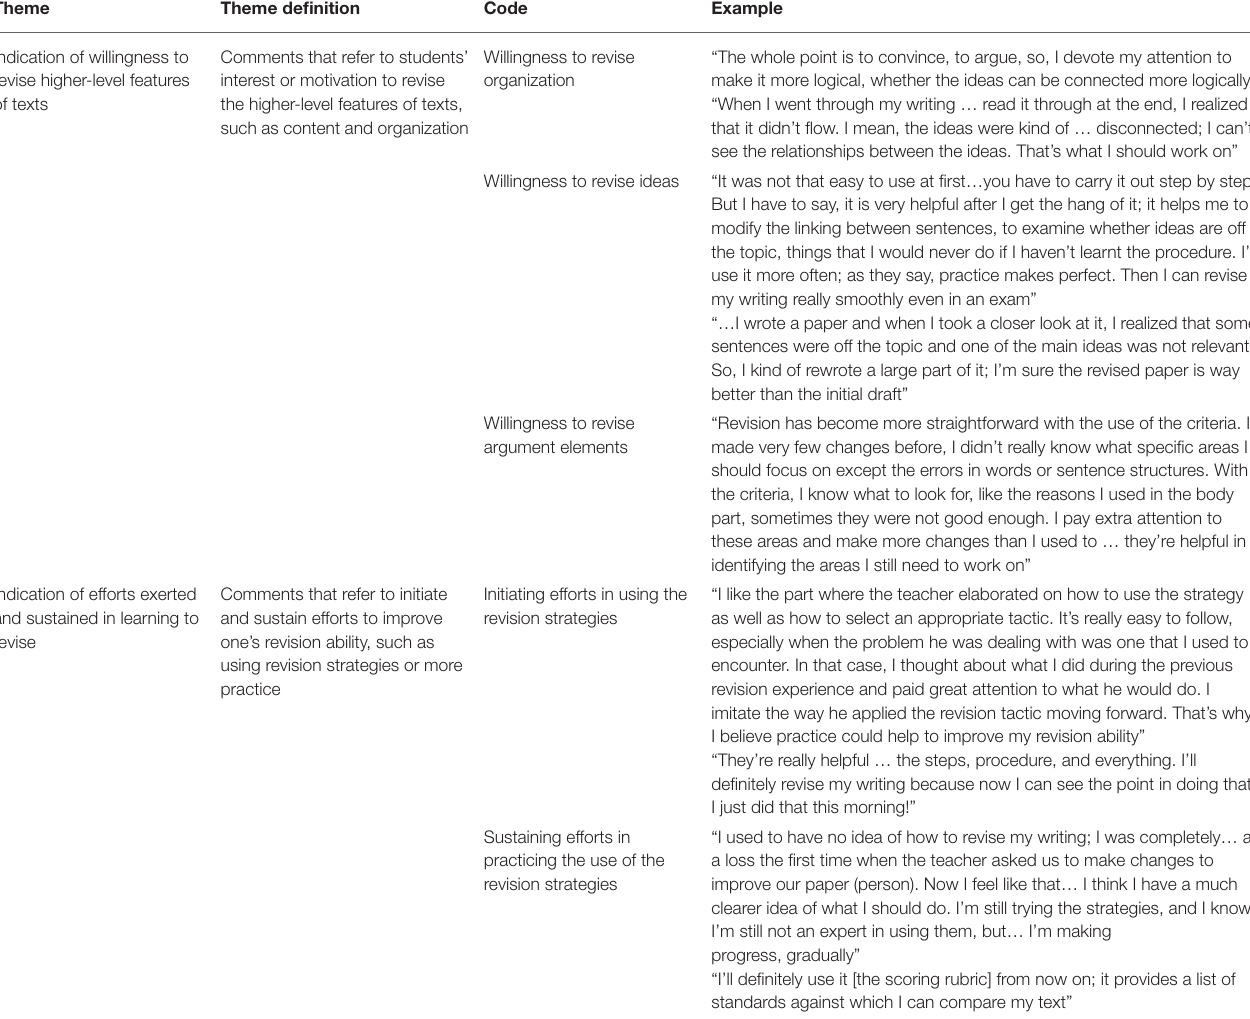
TABLE 4 | Themes and codes identified in post-test